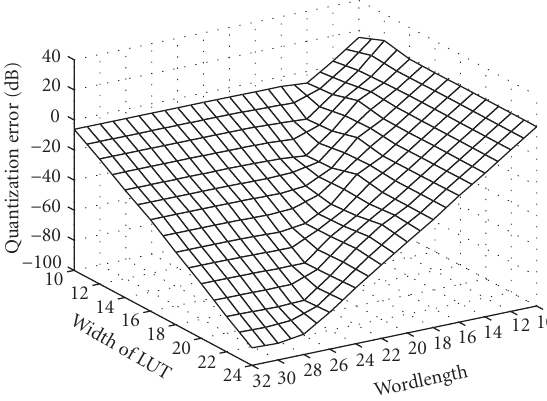
Figure 7: Mesh plot showing the quantization errors of implemen- tations with varying wordlengths and DA ROM